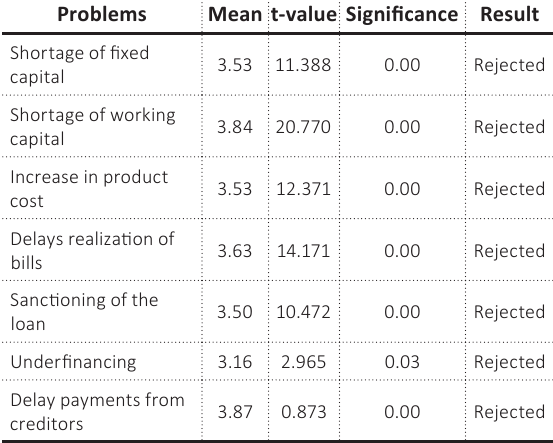
Table 6. Technology